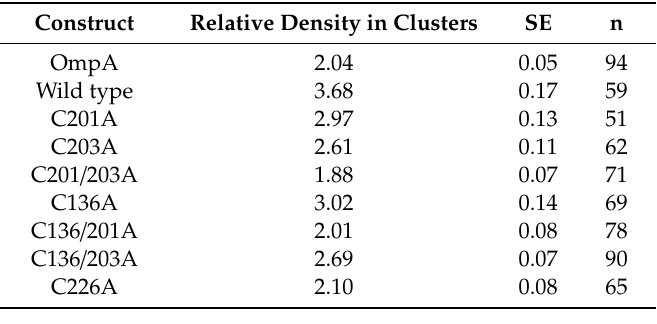
Table 1. The relative cluster densities and associated standard errors of OmpA, wild ‐ type rMOMP, and rMOMP cysteine mutants. Direct stochastic optical reconstruction microscopy (dSTORM) localisation data were analysed with ClusDoC software before the mean and standard error were calculated for each sample. All data were collected and processed under the same conditions. SE, standard error; N, number of cells analysed.